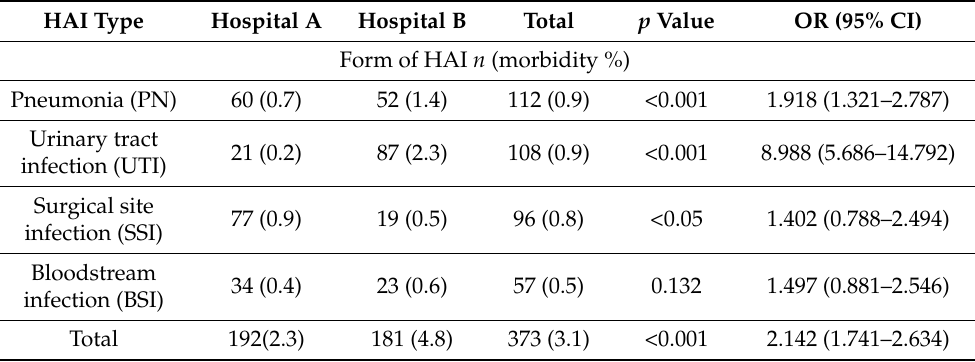
Table 2. Clinical forms and numbers of HAIs, incidence of HAIs per 100 hospitalizations, Odds Ratio in the years 2014–2019.